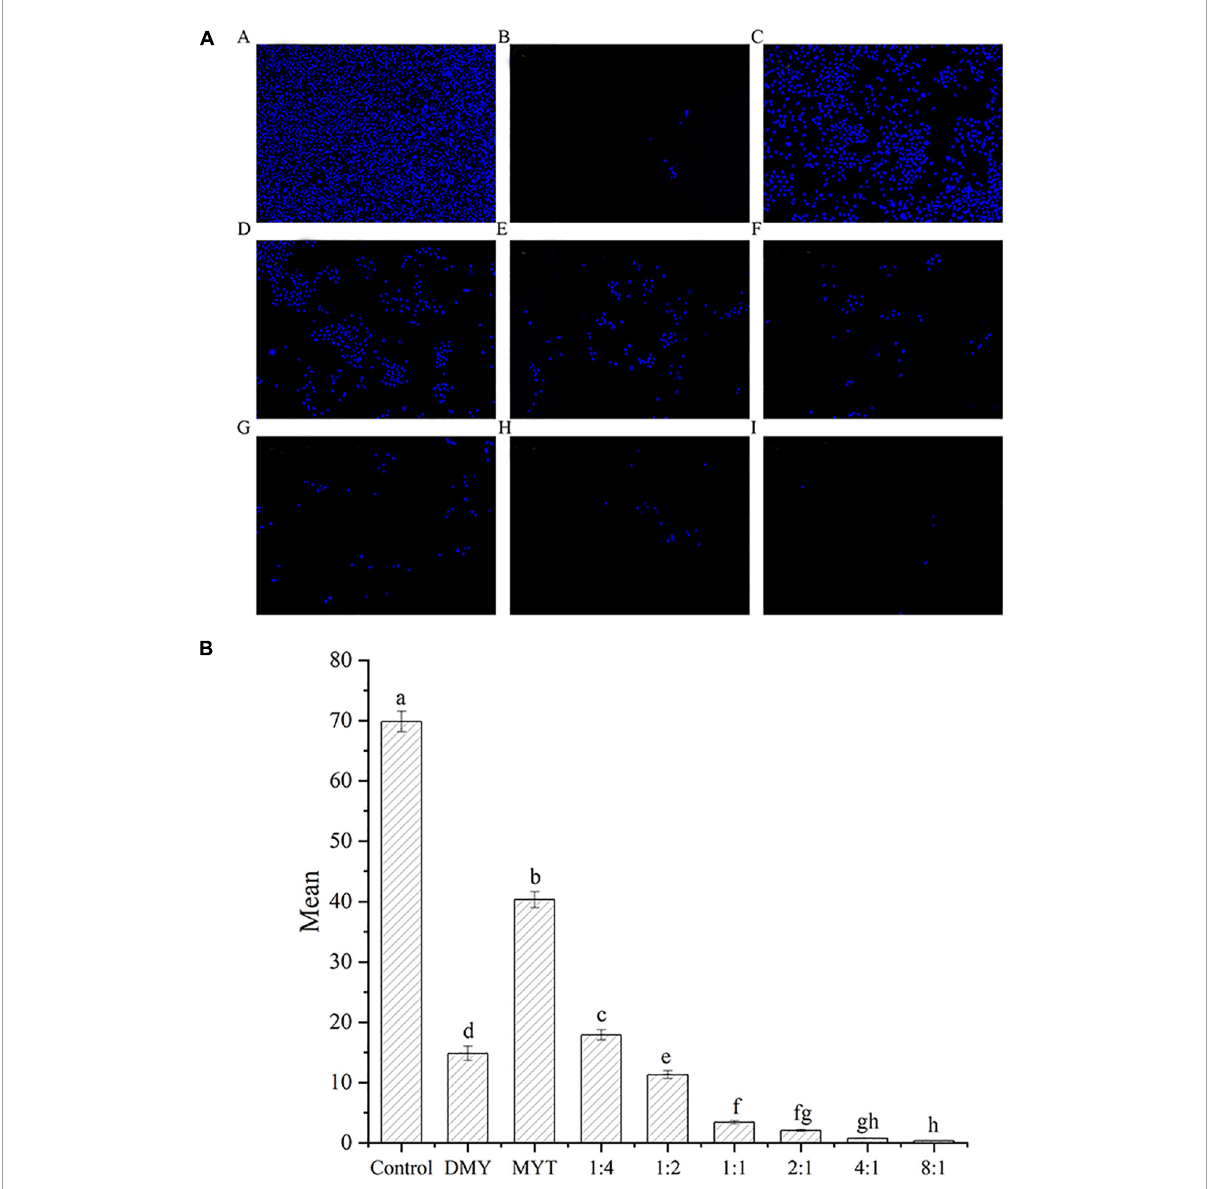
FIGURE8 Analysis of the synergistic inhibitory effect of DMY and MYT on cell proliferation by fluorescence staining. Cell viability was determined by Hoechst 33342 fluorescent staining and pictures were quantified with ImageJ. Values are means ± SD ( n = 3). Different letters indicate significant differences between means at P < 0.05 by one-way ANOVA followed by Duncan comparison test. (A) Fluorescence photography. (B) Fluorescence quantitative analysis. (A) Control. (B) DMY. (C) MYT. (D) DMY: MYT = 1:4. (E) DMY: MYT = 1:2. (F) DMY: MYT = 1:1. (G) DMY: MYT = 2:1. (H) DMY: MYT = 4:1. (I) DMY: MYT = 8:1. DMY, dihydromyricetin; MYT, myricitrin; Mean, mean gray